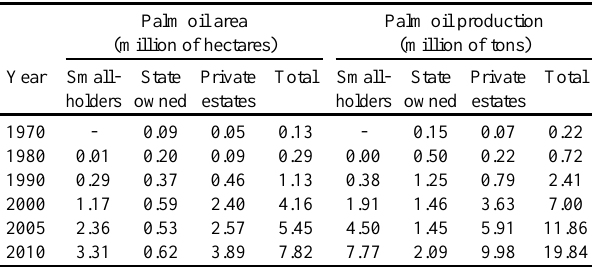
Table 1 . Oil palm area and palm oil production 1970-2010. Palm oil area (million of hectares)